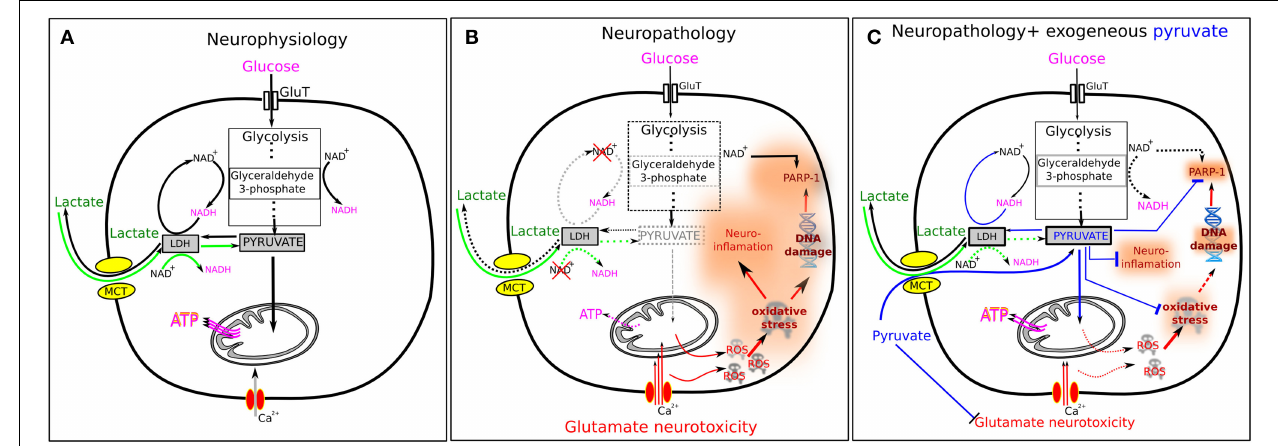
FIGURE 1 | Pyruvate and lactate in normal and pathological conditions. (A) In normal conditions, glucose enters the cell via glucose transporters (GluT) and is metabolized in a 10-step glycolysis. Endogenous pyruvate is a final product of glycolysis and the main energy substrate for ATP generation in mitochondria. Excessive for mitochondria pyruvate can be transformed to lactate by lactate dehydrogenase (LDH) in the presence of NADH. Extracellular lactate can enter the cell via monocarboxylate transporters (MCT). Lactate then is converted to pyruvate by LDH in the presence of NAD + (green arrows). This explains why extracellular lactate may serve efficiently as the energy fuel for brain cells. (B) The situation is changed radically under pathological conditions. A number of neurological disorders are characterized by the oxidative stress and increased level of interstitial glutamate—both factors inducing strong excitotoxicity. Oxidative stress results from excessive presence of ROS, while glutamate induces cellular overload with Ca 2 + ions. ROS induce DNA damage leading to the overactivation of poly-ADP ribose polymerase-1 (PARP-1) that results in depletion of cytosolic NAD + . ROS also activate the pro-inflammatory transcription factor NF-kB inducing neuroinflammation. Depletion of NAD +